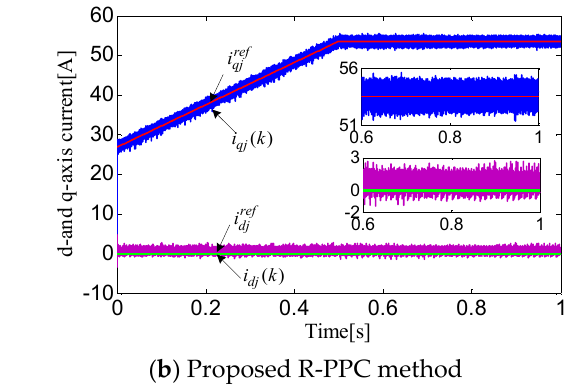
Figure 7. Simulation results of the d- and q-axis current under the charge state. ( a ) Conventional PPC method; ( b ) Proposed R-PPC method.